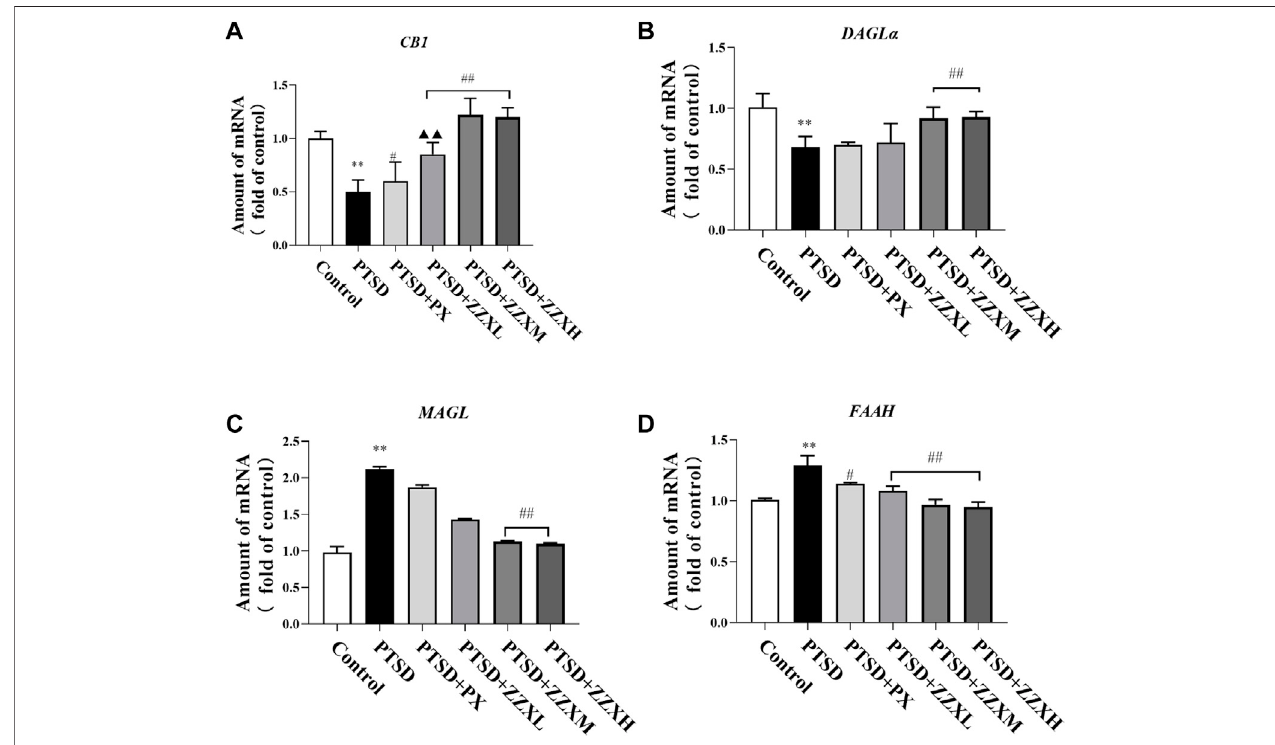
FIGURE9| EffectsofZZXtreatmentonCB1 (A) ,DAGL α (B) ,MAGL (C) ,andFAAH (D) mRNAexpression.Valuesareexpressedas(mean ± SEM, n (cid:2) 5).* p < 0.05, ** p < 0.01 vs control group. # p < 0.05, ## p < 0.01 vs PTSD group. ▲ p < 0.05, ▲▲ p < 0.01 vs ZZXM group.